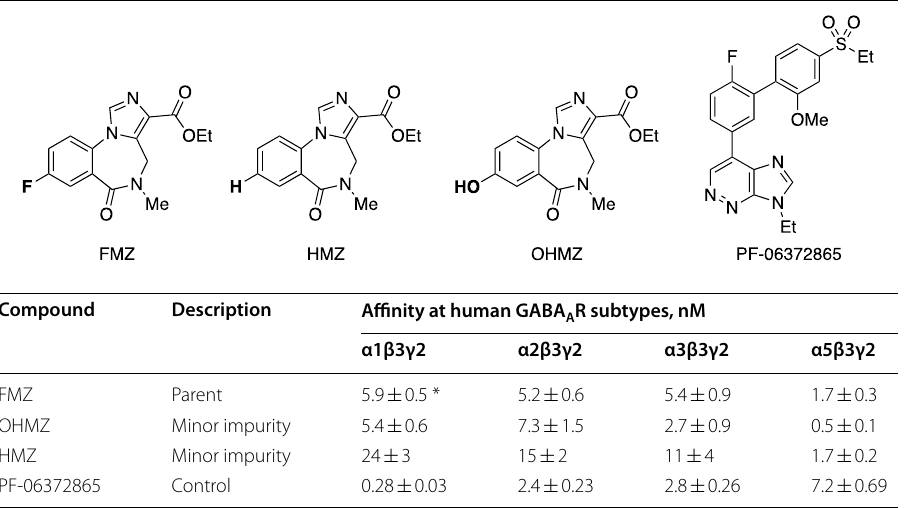
*Values shown are mean